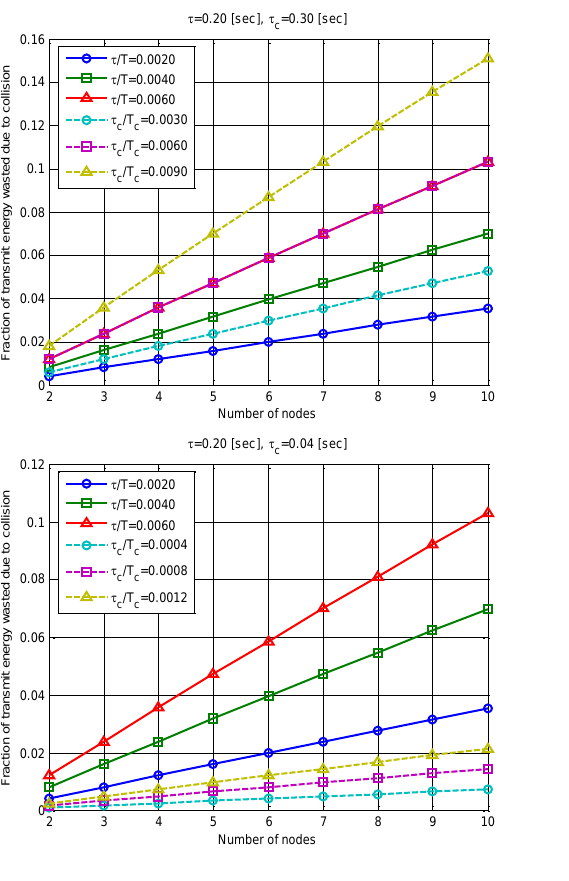
Figure 10. Fraction of transmit energy wasted due to